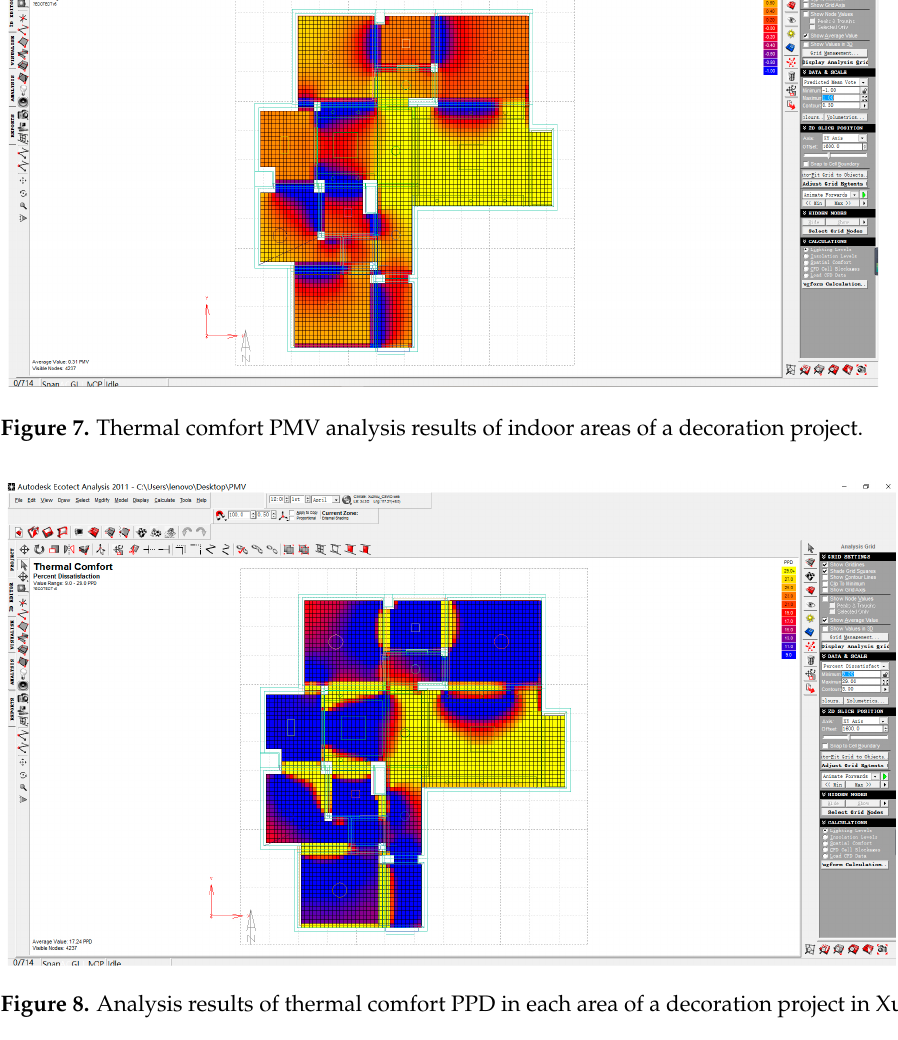
Figure 7. Thermal comfort PMV analysis results of indoor areas of a decoration project.